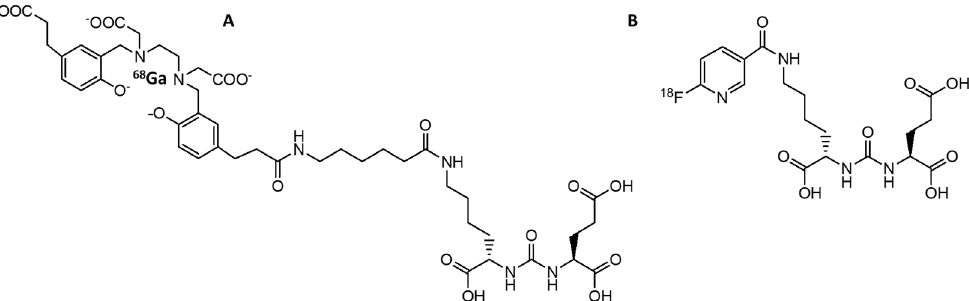
Figure 5. PET tracers approved by the FDA for PSMA-targeted imaging of PCa. ( A ) [ 68 Ga]Ga-PSMA- 11; ( B ) [ 18 F]DCFPyL.